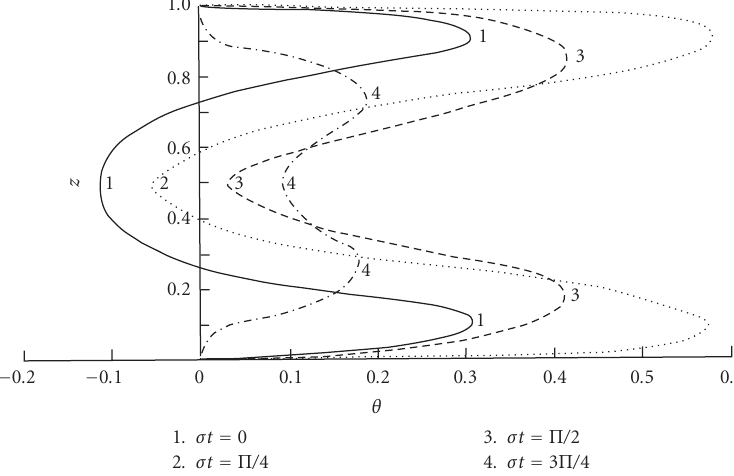
Figure 6.4. Unsteady temperature profiles in two-phase fluid when E c P r = 300, k = 0 . 3, λ 1 = 0 . 1, λ 2 = 0 .